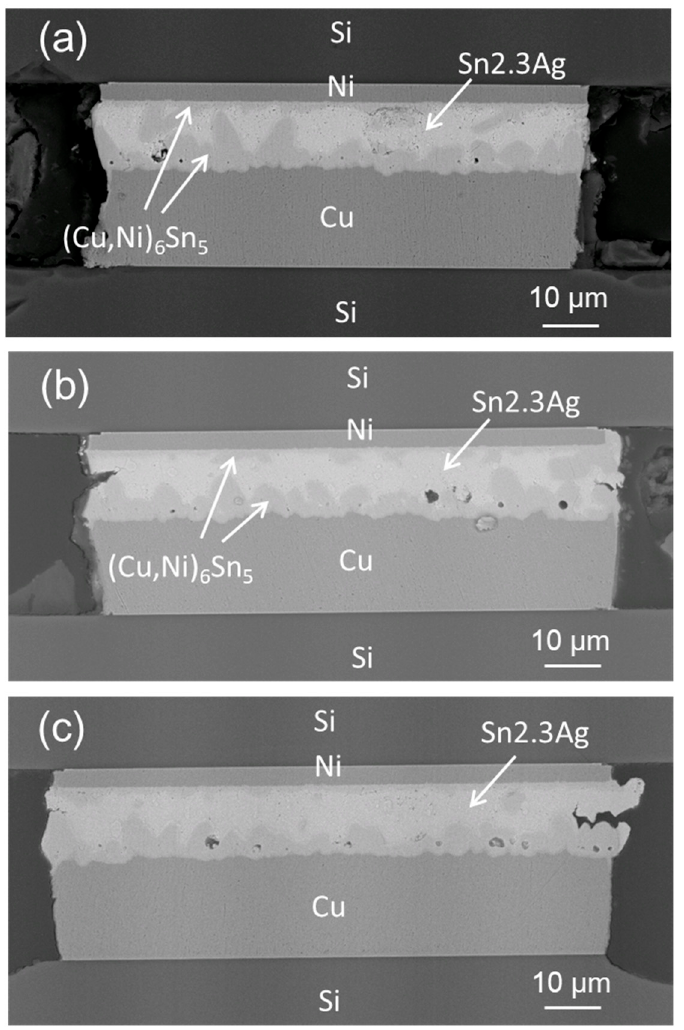
Figure 2. Cross-sectional SEM BEIs of the non-IMC-bridging Ni/solder/Cu microbumps ( a ) as-fabricated after a TCT for ( b ) 1000 cycles and ( c ) 2000 cycles. Arrows designate the IMCs.